Question: Write a caption explaining this figure to a reader.
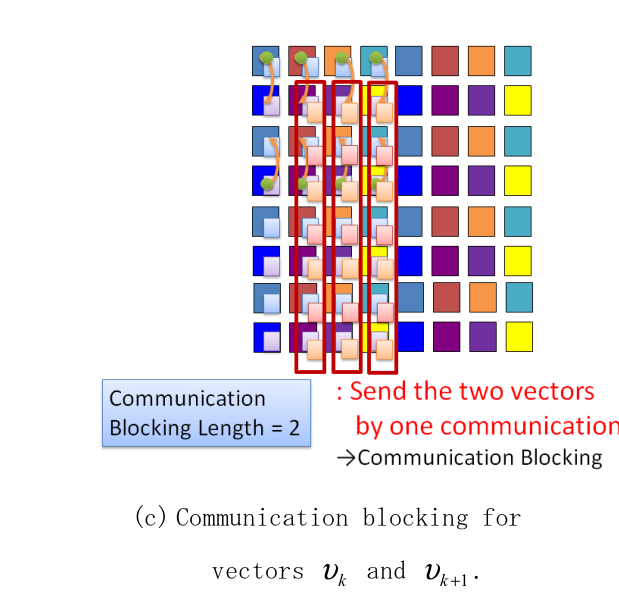
Answer: A snapshot of communication blocking for HIT. Process